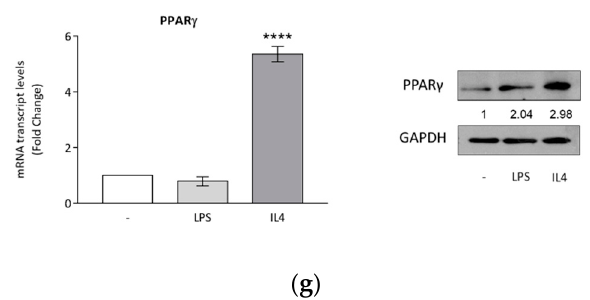
Figure 1. Di ff erentiation and polarization of THP-1 monocytes. ( a ) Representative bright field images by optical microscopy of morphological changes in THP-1 monocytes (-) di ff erentiated into mature macrophages M0 in the presence of 16 nM or 100 nM PMA for 24 h. The scale bar represents 50 µ m. ( b ) Macrophages derived from the stimulation with PMA 100 nM (M0), after replacement of PMA-containing medium with fresh medium (without PMA) for 1 day, were treated with LPS 10 ng / mL or IL4 20 ng / mL for 24 h to obtain M1 and M2 macrophages, respectively. Human cytokine arrays were used for the detection of secreted proteins in conditioned media derived from M1 and M2 macrophages after 24 h of polarization. Raw numerical densitometry data were extracted and the background subtracted. Results were shown as mean pixel density. Real-time RT-PCR of M1 markers IL6, IL1 β , TNF α ( c ) and M2 markers CD163, IL10 and IL1Ra ( d ) in M0 macrophages (-) treated with LPS 10 ng / mL for 6 h or IL4 20 ng / mL for 72 h. Each sample was normalized on its RPS27A mRNA content. ELISA analyses of IL6 ( e ) and IL1Ra ( f ) proteins were performed in conditioned media of polarized macrophages. Values represent means ± SDs of three di ff erent experiments, each performed with duplicate samples. Results are expressed as fold changes compared to M0 macrophages (-). ( g ) Real-time RT-PCR and immunoblotting of PPAR γ in M0 macrophages (-) treated with LPS 10 ng / mL or IL4 20 ng / mL for 24 h. Each sample was normalized on its 18S RNA content. Glyceraldehyde-3-phosphate dehydrogenase (GAPDH) was used as a loading control. Numbers below the blots represent the average fold change between PPAR γ and GAPDH protein expression versus M0 macrophages. Results are expressed as fold changes compared to M0 macrophages, * p < 0.05, ** p < 0.005, *** p < 0.0005, **** p < 0.0001, ns = not significant.